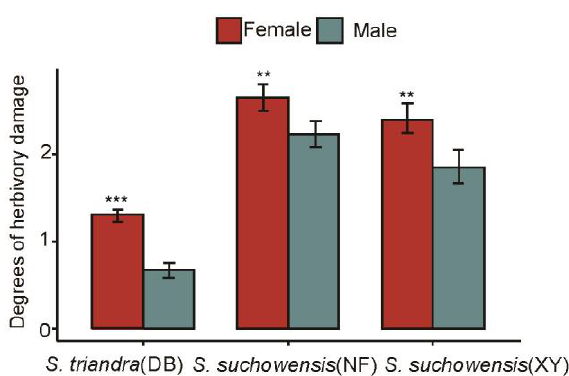
Figure 1. Degrees of herbivory damage on male and female of willow plants. Notes: Bars represent SE. Comparisons between females and males within each variable were performed using the pairwise t-test. ** p < 0.01; *** p <0.001.